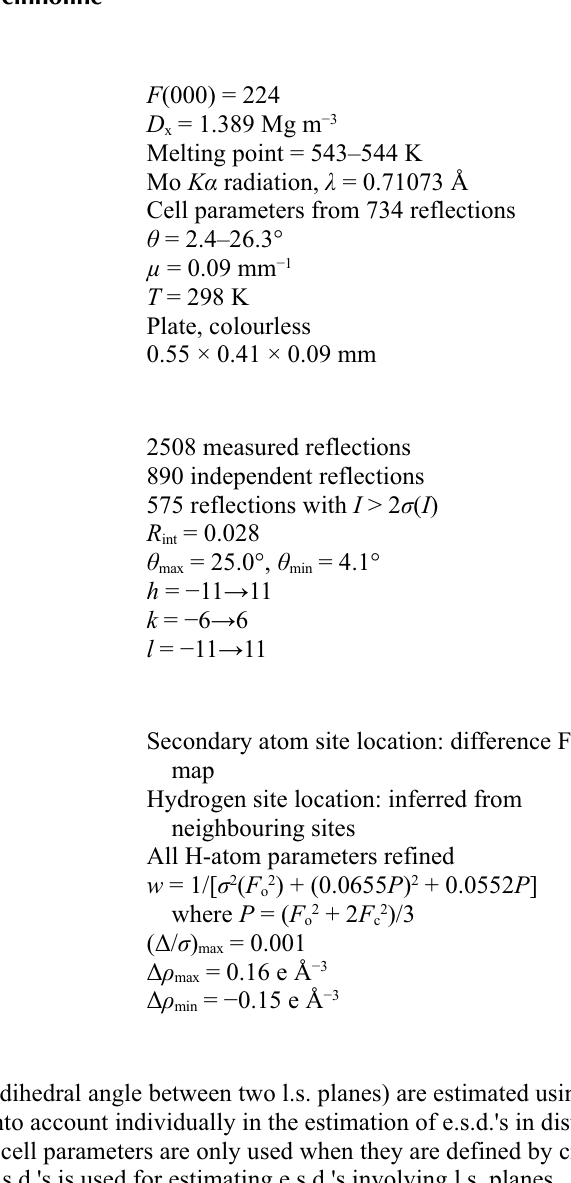
Molecular packing in the title compound, viewed approximately along the a axis.